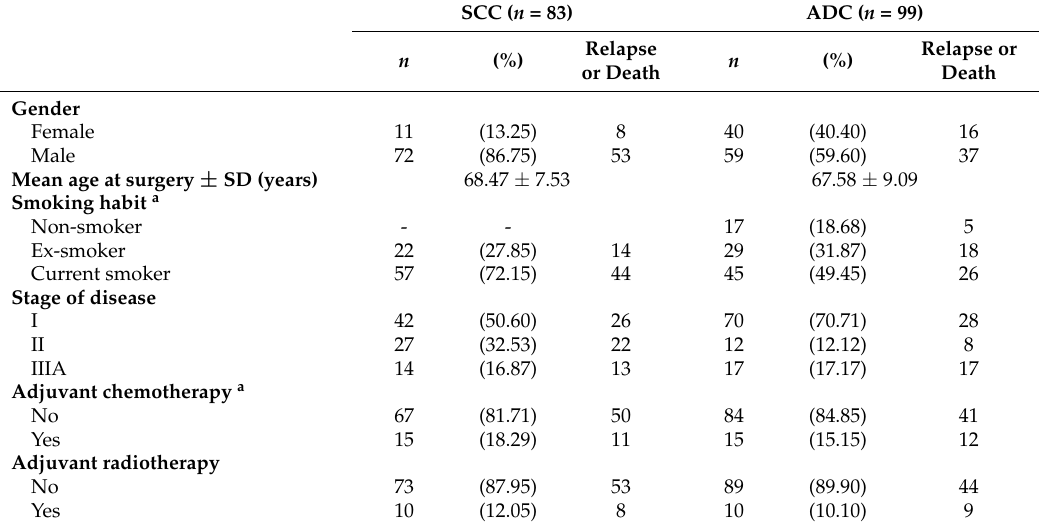
Table 1. Patient characteristics of the analyzed